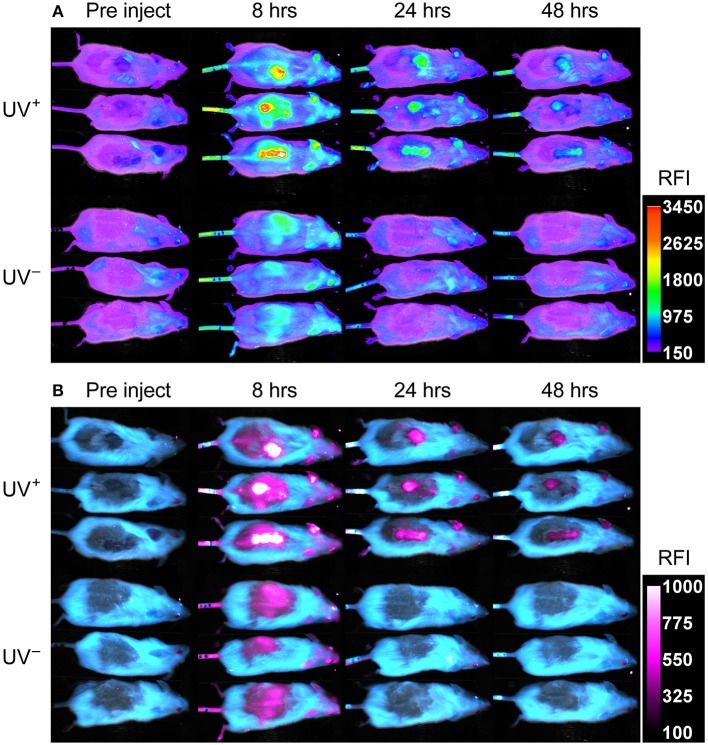
PA-Cy5 is highly specific to cutaneous SCC in vivo. Two groups of HPV38E6E7-FVB mice were imaged prior to injection, 8, 24, and 48 h post injection of 75 μg PA-Cy5 via tail vein. The UV+ group has developed squamous cell carcinomas on their back. The UV− group is of a similar age to the UV+ group but have not been exposed to UV irradiation. Fluorescent in vivo optical images of PA-Cy5 using 630 nm excitation/700 nm emission (A). Localization of PA-Cy5 to the SCC tumors is observed reaching peak relative fluorescence intensity (RFI) ~8 h post injection. Exclusive detection of tumors can be observed by 24 h post injection, where control animals reach background levels of fluorescence. Spectrally unmixed in vivo optical images (B). A series of images were taken at each time point using multiple excitation wavelengths, measuring the emission at 700 nm. Optical spectra were modeled for fur auto-fluorescence and PA-Cy5 fluorescence using Bruker Multispectral software. These models were applied to the images, isolating the signal from the fur (cyan) and PA-Cy5 (magenta), demonstrating the tumor specific localization of PA-Cy5. Fluorescence arising from PA-Cy5 is undetectable in the skin 24 h post injection, but remains localized to the tumor 48 h post injection. The calibration bars represent relative fluorescence intensity (RFI). Fluorescence data is overlaid on reflectance (white light) images.